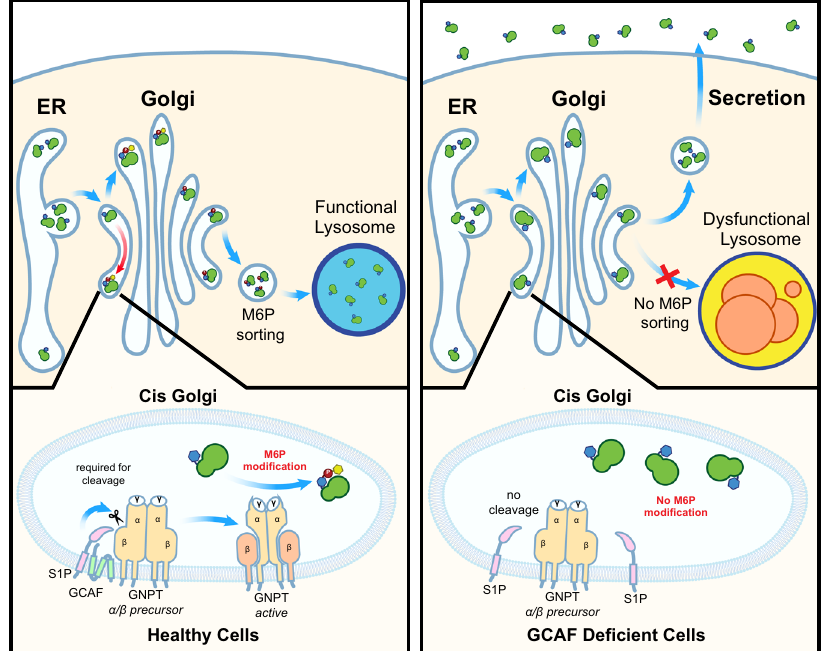
Fig. 8 | A model showing TMEM251/GCAF is required for the cleavage and activation of GNPT α / β precursor. TMEM251/GCAF de fi ciency leads to defects in M6P modi fi cation of lysosomal enzymes at the cis-Golgi. Lysosomal